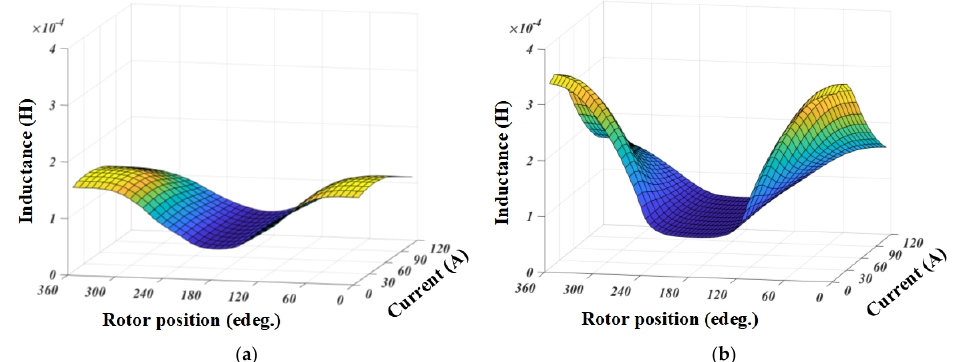
Figure 6. Three-dimensional inductance curves. ( a ) Traditional 12/8 SRM; ( b ) Proposed 6/5 SRM.